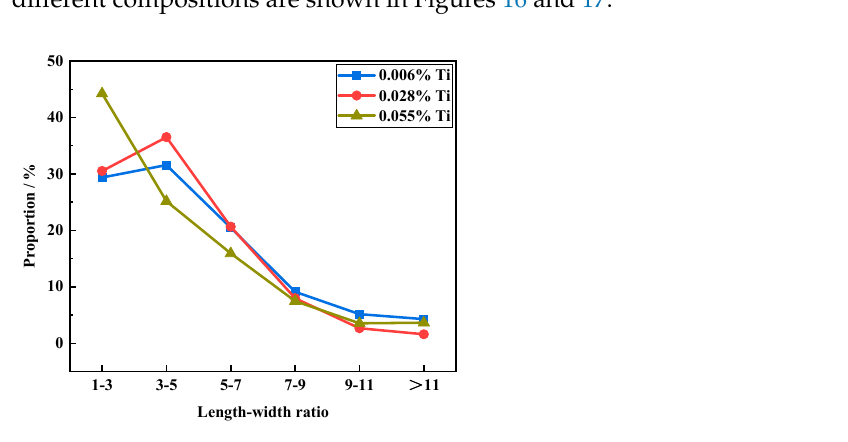
Figure 16. Variation of length–width ratio of sulfides in steels with different compositions under rolling condition.